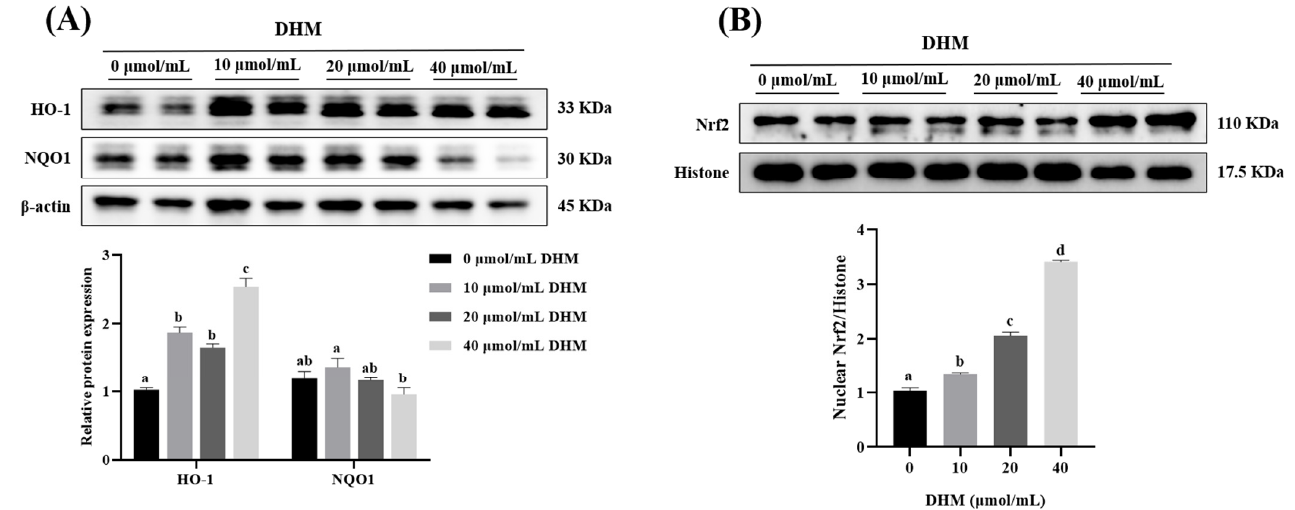
Figure 2. Effect of DHM on the protein expression of HO-1, NQO1, and nuclear Nrf2 in IPEC-J2 cells. IPEC-J2 cells were treated with DHM (0, 10, 20, 40 µ mol/mL) for 36 h. ( A ) The protein levels of HO-1 and NQO1. ( B ) The protein level of nuclear Nrf2. Data are expressed as the mean ± SE. Values with different superscript letters are significantly different ( p < 0.05).